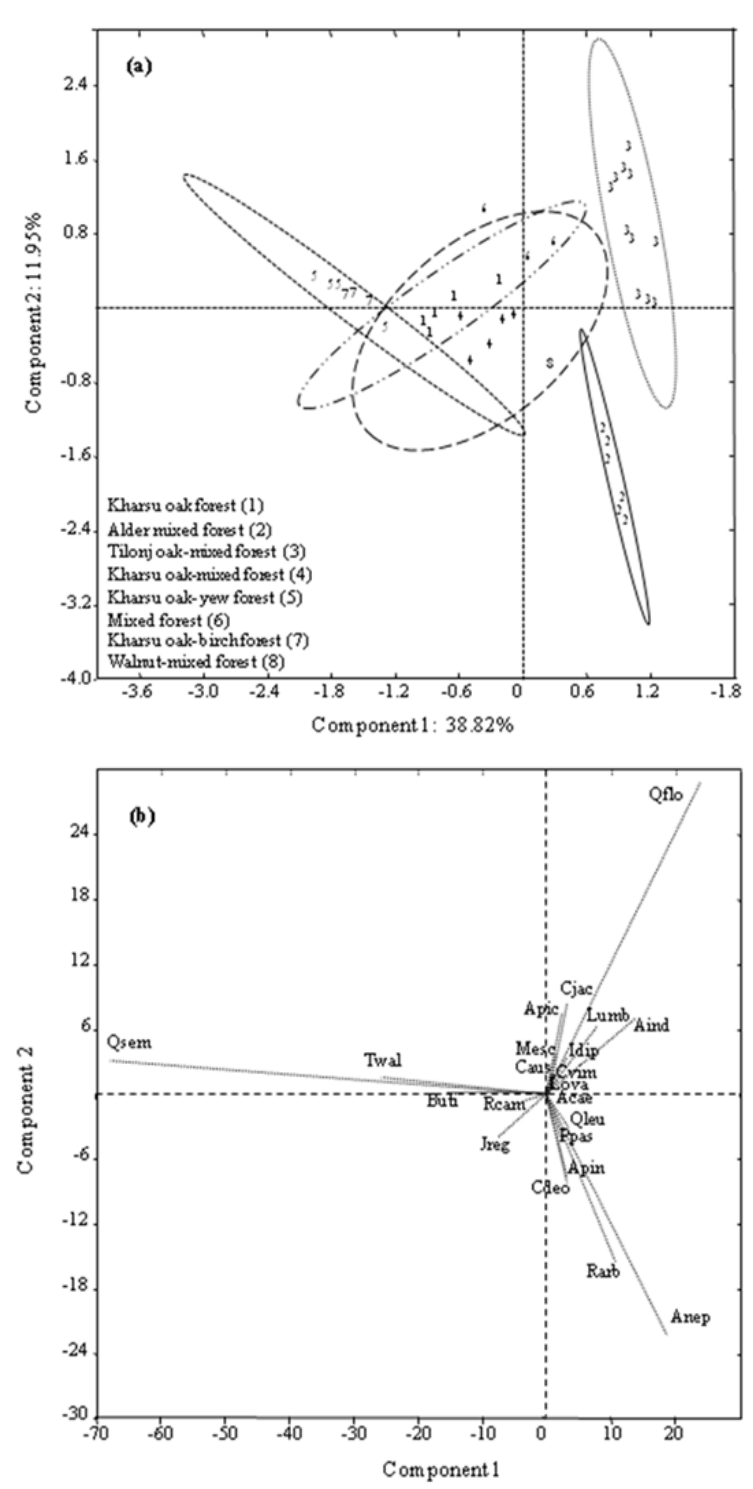
Fig. 2. Forest communities in Chenab valley identified through Principle Component Analysis. The abbreviations used in Fig. (2a) 1: Kharsu oak forest, 2: Alder-Mixed forest, 3: Tilonj oak-Mixed forest, 4: Kharsu oak-Mixed forest, 5: Kharsu oak-Yew forest, 6: Mixed forest, 7: Kharsu oak-Birch forest and 8: Walnut-Mixed forest, in Fig. (2b) Qsem: Quercus semecarpifolia , Qflo: Q. floribunda , Qleu: Q. leucotrichophora , Lumb: L. umbrosa , Idip: I. dipyrena , Mesc: Myrica esculenta , Caus: Celtis australis , Rarb: Rhododendron arboreum , Rcam: R. campanulatum , Twal: Taxus wallichiana , Buti: Betula utilis , Jreg: Juglans regia , Cdeo: Cedrus deodara , Apin: Abies pindrow , Anep: Alnus nepalensis , Ppas: Pyrus pashia , Cvim: Carpinus viminea , Lova: Lyonia ovalifolia , Acae: Acer caesium , Apic: A. pictum and Aind: Aesculus